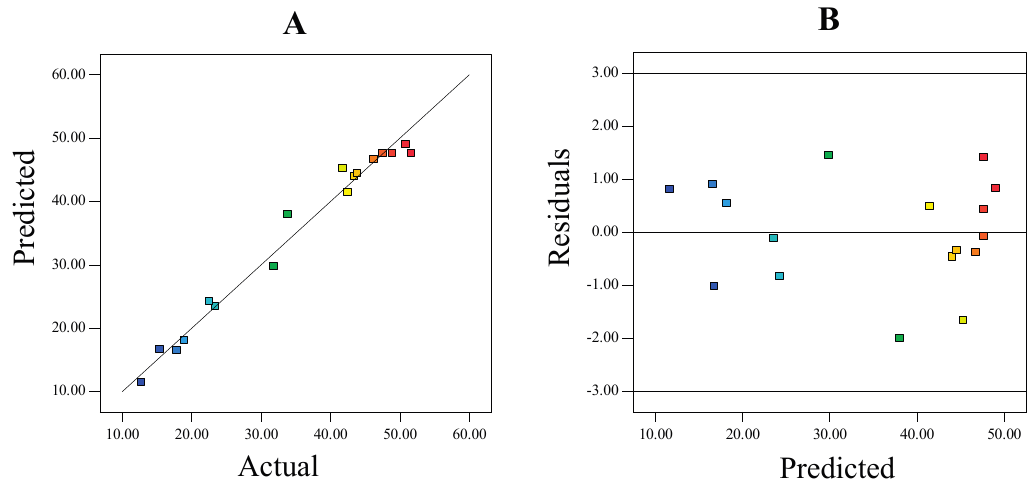
Figure 1. Diagnostic plots for the H 2 -concentration model. ( A ) Correlation between measured and predicted response; and ( B ) scatterings of residuals against predicted values of response.